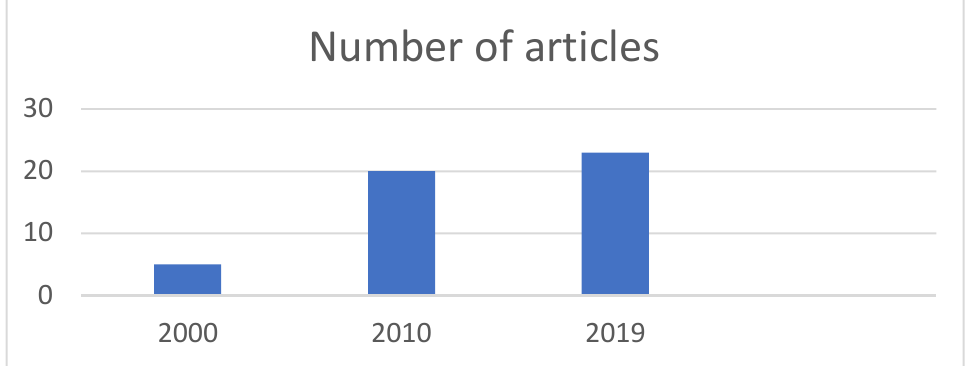
Figure 1. Number of articles detected in Web of Science from 2000 to 2019.